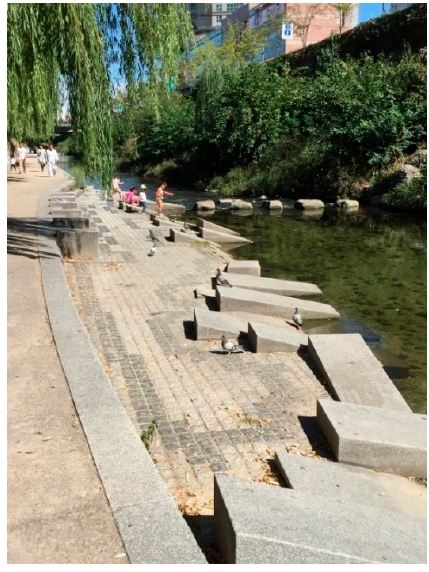
Figure 16. Laundry area.